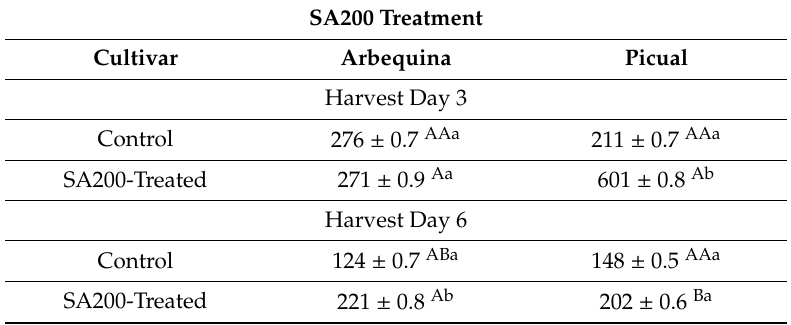
Data are presented as means of three independent samples. Di ff erent superscript bold upper-case letters in the same row between cultivars within the control samples and the same harvest day indicate di ff erences at p < 0.05. Di ff erent superscript normal upper-case letters in the same column between harvest days 3 and 6 within the same type of sample (control and treated) and same cultivar indicate di ff erences at p < 0.05. Di ff erent superscript lower-case letters in the same column between control and treated samples within the same harvest day and same cultivar indicate di ff erences at p <